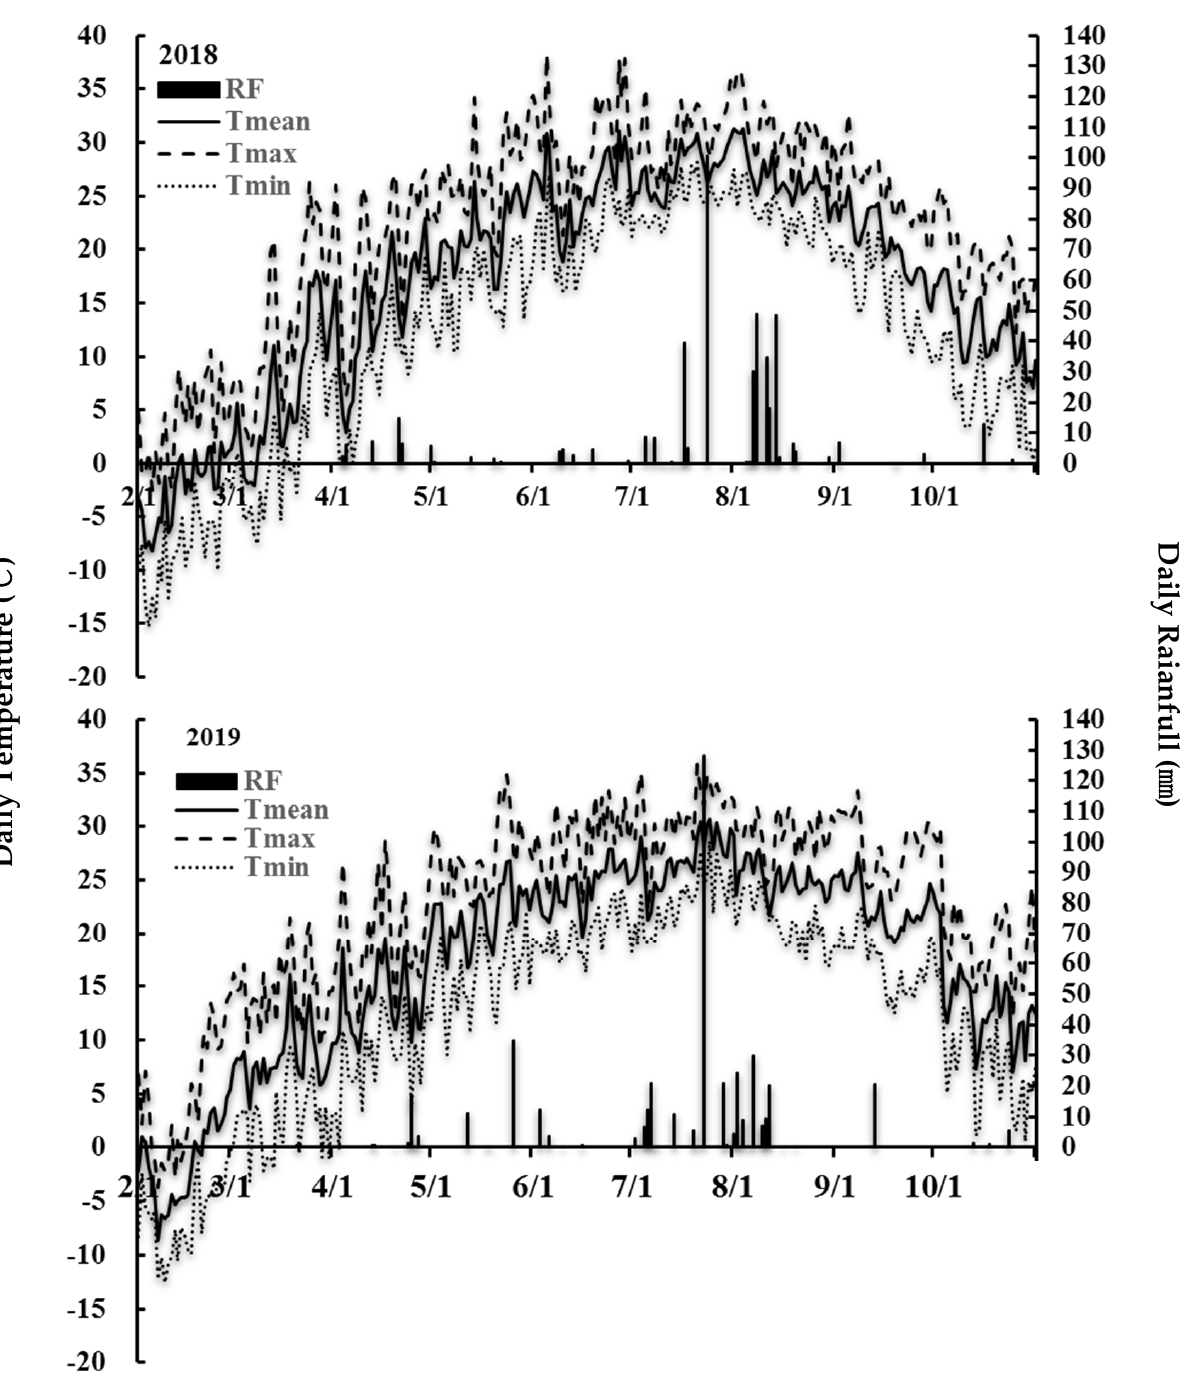
Figure 1. Daily meteorological data over the growing duration of spring wheat and summer maize in 2018 and 2019.